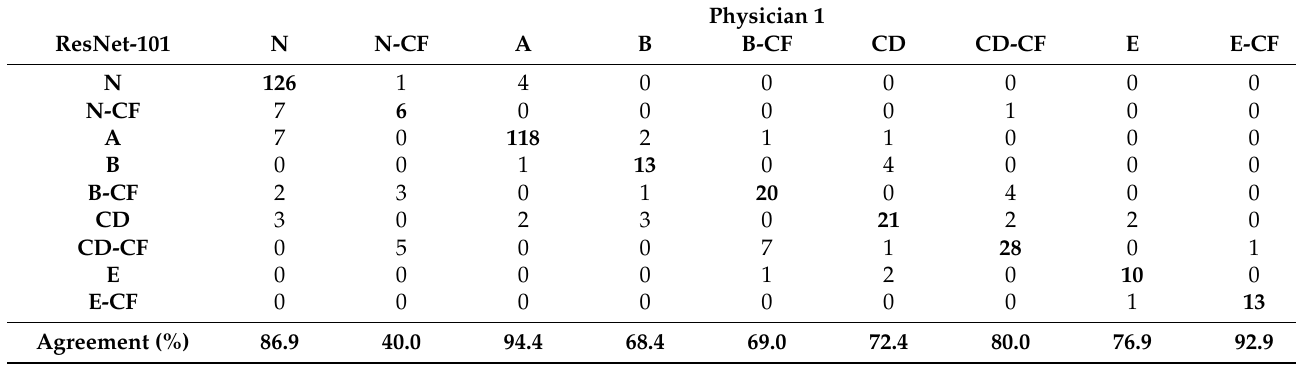
Table 2. Comparison of ResNet-101 waveform categorization with the reference vascular medicine physician according to the simplified Saint-Bonnet